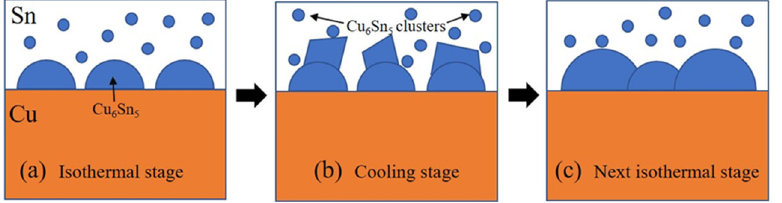
Figure 4. Sketch for the growth behavior of Cu 6 Sn 5 during multiple reflows. ( a ) Isothermal stage, ( b ) Cooling stage, ( c ) Next isothermal